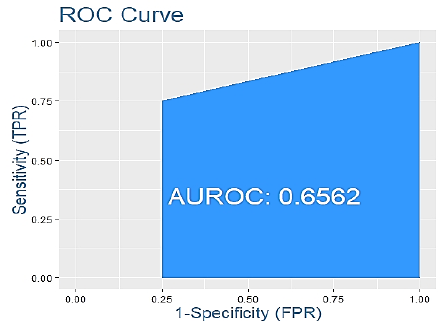
Figure 8. Area under ROC curve for Naive